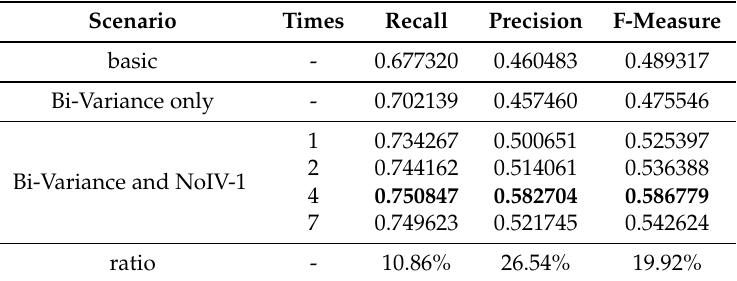
Table 1. Results of KDE executed on three scenarios.